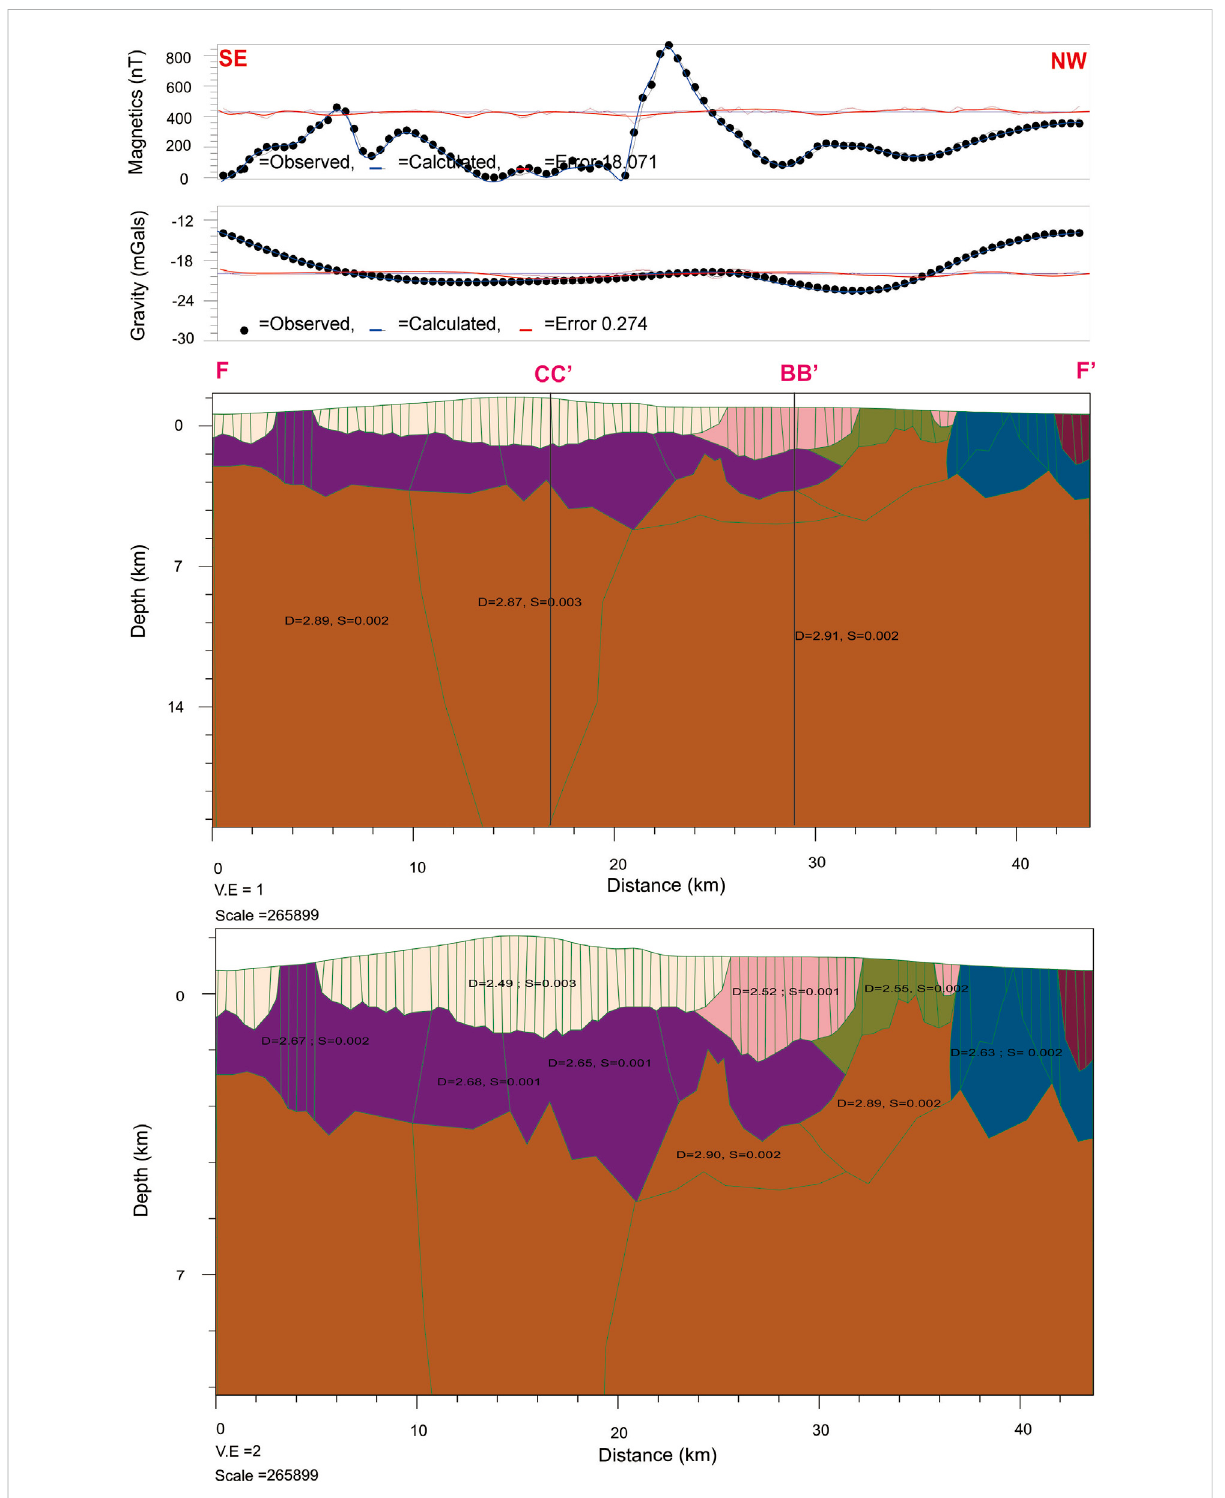
FIGURE 8 2D modeling of magnetic and gravity data of the F-F ′ pro fi le in the Sianok segment of GSF. See the text for details. This fi gure uses the same legend as that in Figure